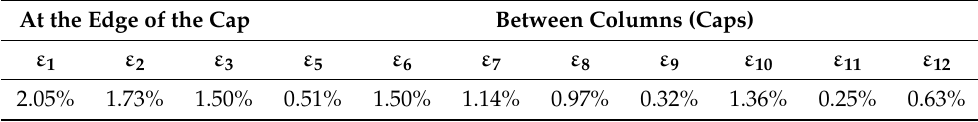
Table 1. Results of geosynthetic strain measurements.